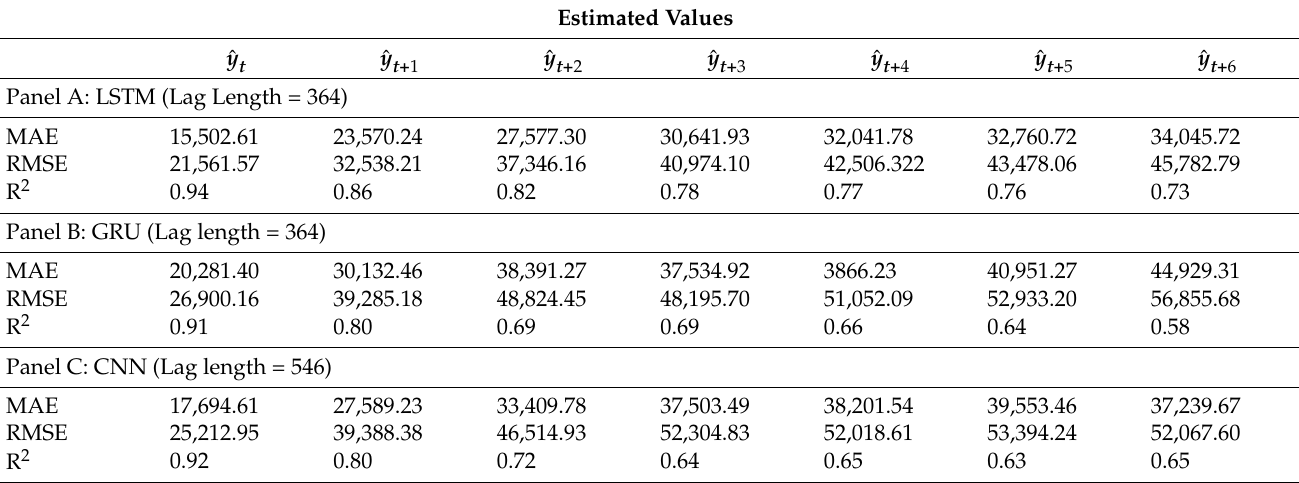
Table 6. Summary of the performance metrics of the investigated models on train set. Estimated